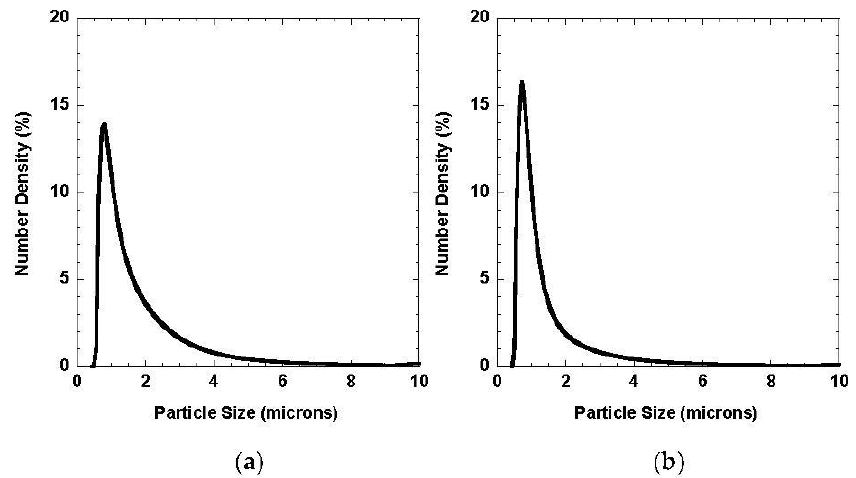
Figure 2. Fits to laser diffraction measurements of ( a ) cement and ( b ) concrete dust.